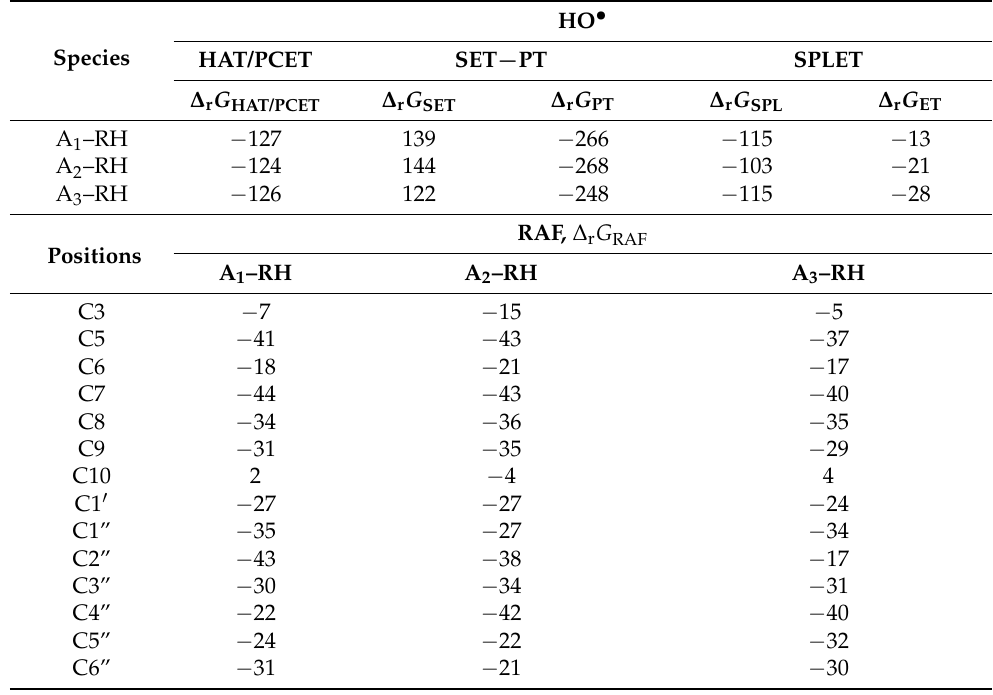
Table 1. Estimated values of reaction Gibbs energies ( ∆ r G ) in kJ · mol − 1 for reactions between coumarin derivatives (A 1 –RH, A 2 –RH, A 3 –RH) and HO • at 298.15